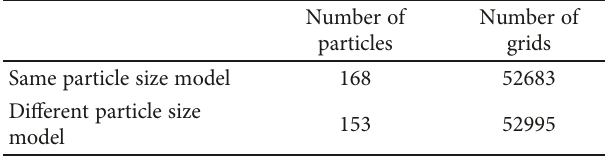
Table 4: Comparison of two kinds of